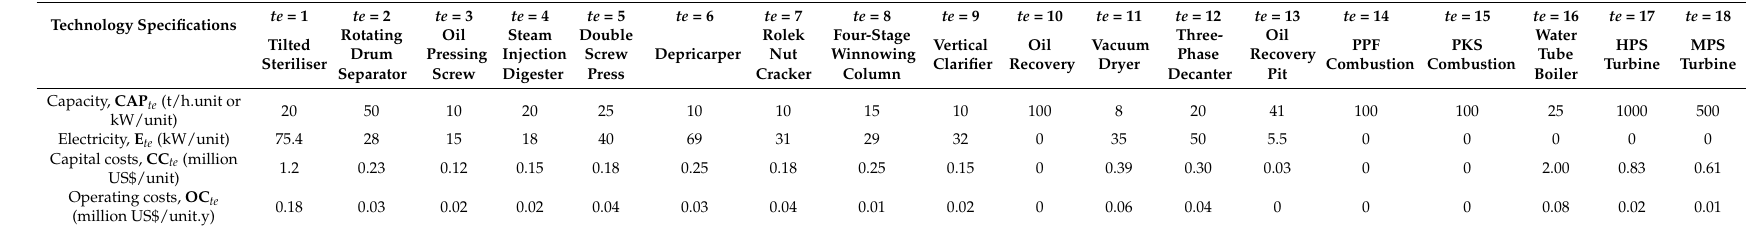
Table 6. Technology specifications for palm oil milling